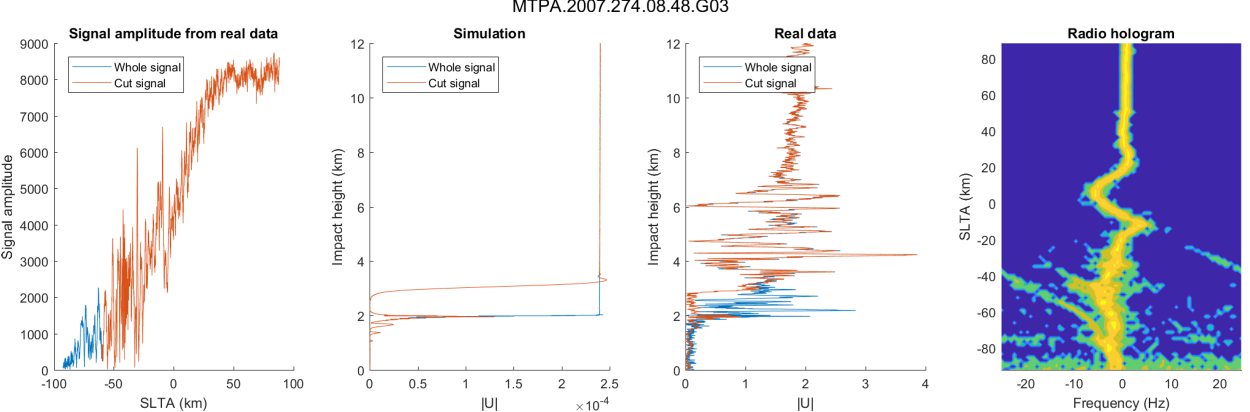
Figure 7. An event classified as category 1. SLTA min is at approximately − 72km, and the signal is truncated at SLTA = − 60km. The reflection spike is located at an impact height of 1940m, and a min is 1993m.